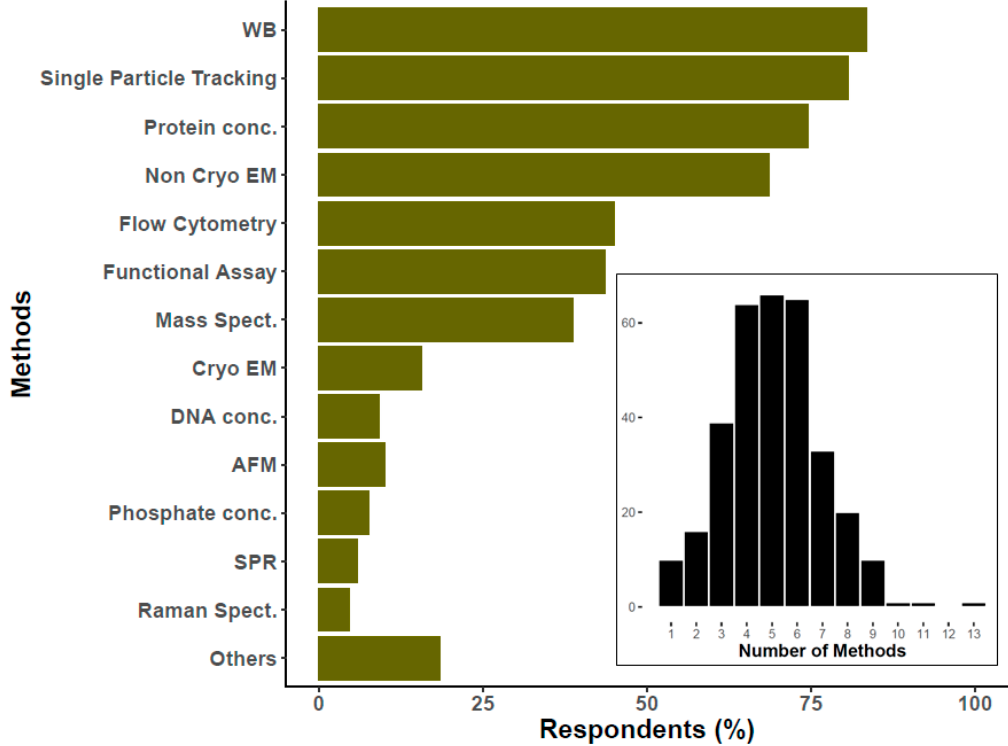
Figure 6. Percentage of researchers that use specific technique to characterize EVs. The histogram at the bottom of the graph reflects the number of researchers ( Y -axis) that use the specified number of methods to characterize EVs ( X -axis). For the main graph, the percentage was calculated over 326 respondents. Please notice that this question had the possibility of multiple answers. Atomic force microscopy (AFM), Cryogenic electron microscopy (Cryo EM), DNA concentration (DNA conc.), Flow cytometry, Functional assays (Functional Assay), Mass spectroscopy (Mass Spect.), others (including among others ELISA, Colorimetric nanoplasmonic, and Next Generation Sequencing), Particle tracking (Single Particle Tracking), Phosphate / phospholipids concentration (Phosphate conc.), Protein concentration (Protein conc.), Raman spectroscopy (Raman), Surface plasmon resonance (SPR), Transmission